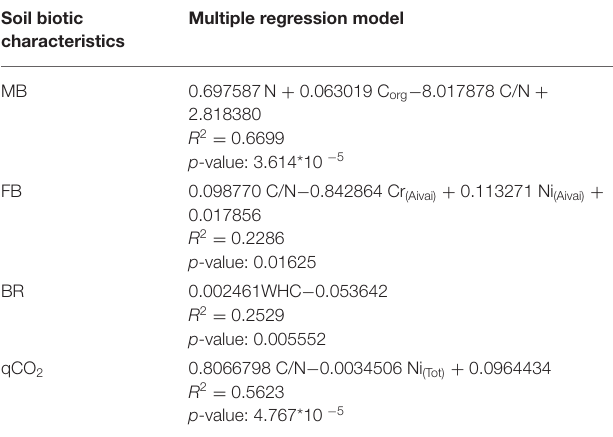
TABLE 4 | Significant results of multiple linear regression analyses of soil biotic (microbial biomass: MB, fungal biomass: FB, basal respiration: BR, metabolic quotient: qCO 2 ) characteristics in relationship with soil abiotic (water holding capacity: WHC, organic carbon: C org , nitrogen concentration: N, C/N ratio, total and available concentration of Cu, Cr, Ni, and Pb)